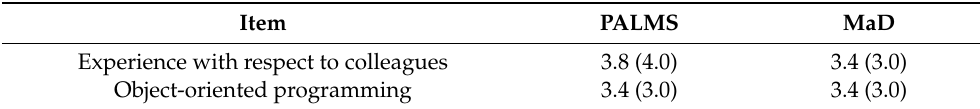
Table 1. Developer programming experience according to a 5-point Likert scale (1: very inexperienced, 5: very experienced) reported as the mean